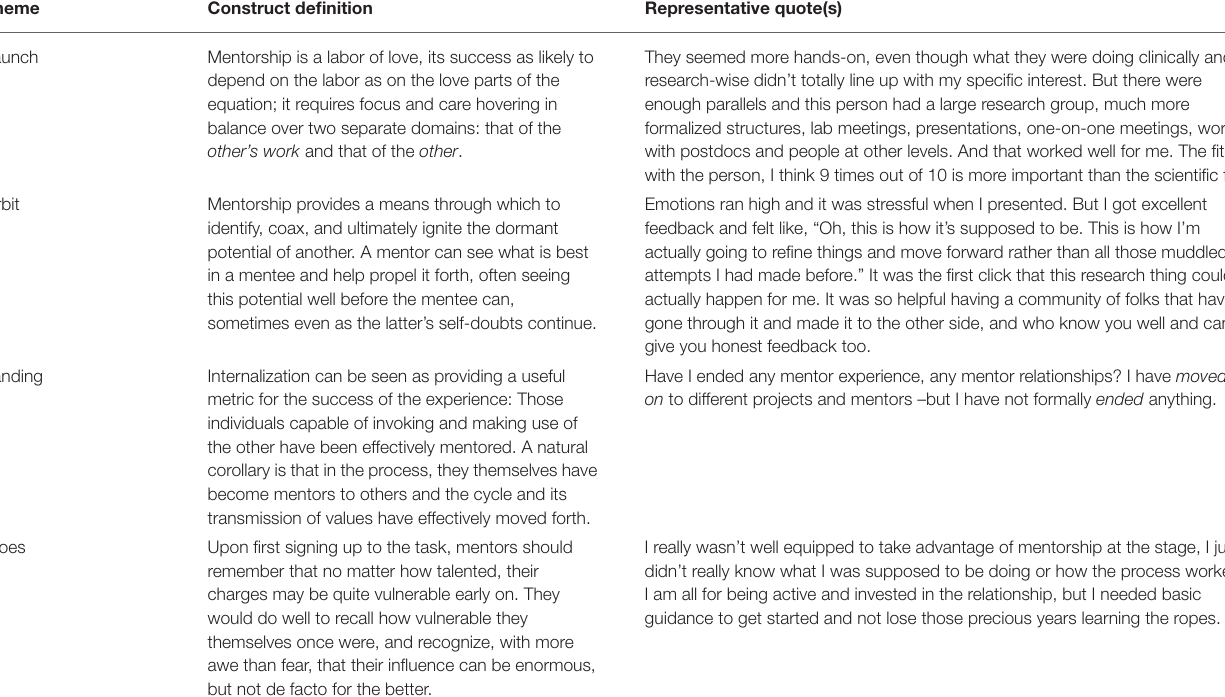
Table’s title, themes, and construct definitions are adapted from (19). of opportunities; they praised and critiqued progress; they guided and pressed gently; but they never pushed to the breaking